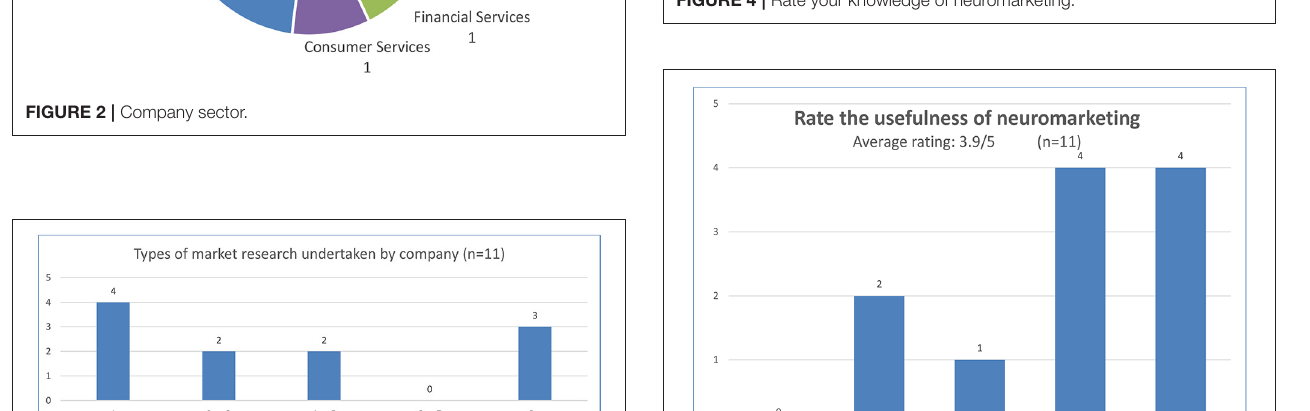
FIGURE 4 | Rate your knowledge of neuromarketing.